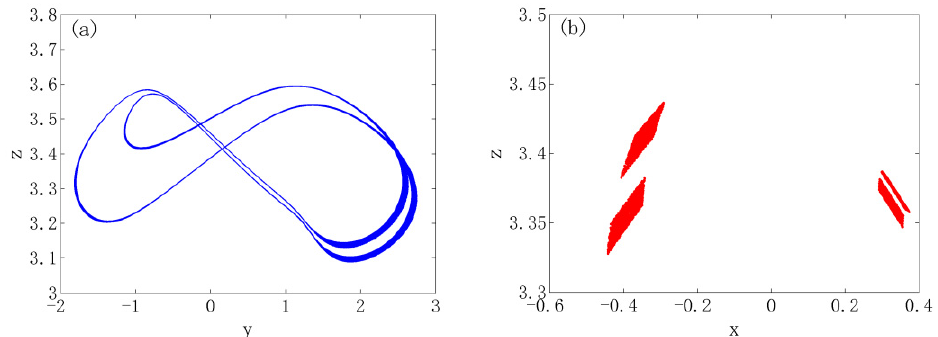
α= . ( a ) Phase trajectory diagram in